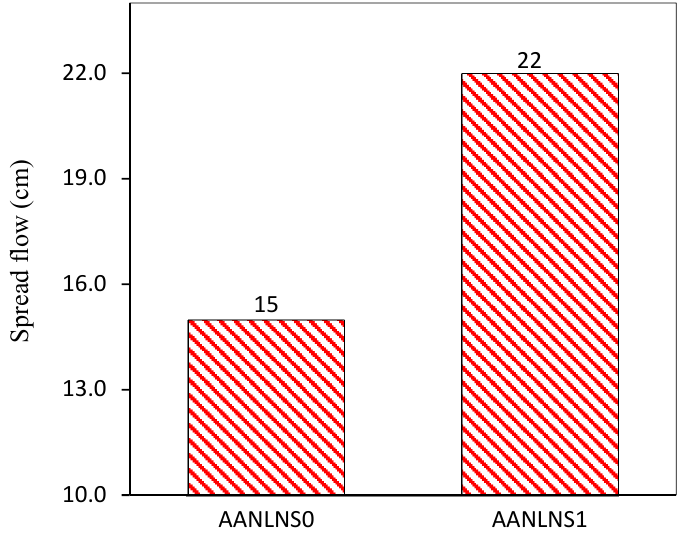
Figure 5. Flowability of the AANLM activated using NaOH only and the combination of NaOH (aq) /Na 2 SiO 3(aq).